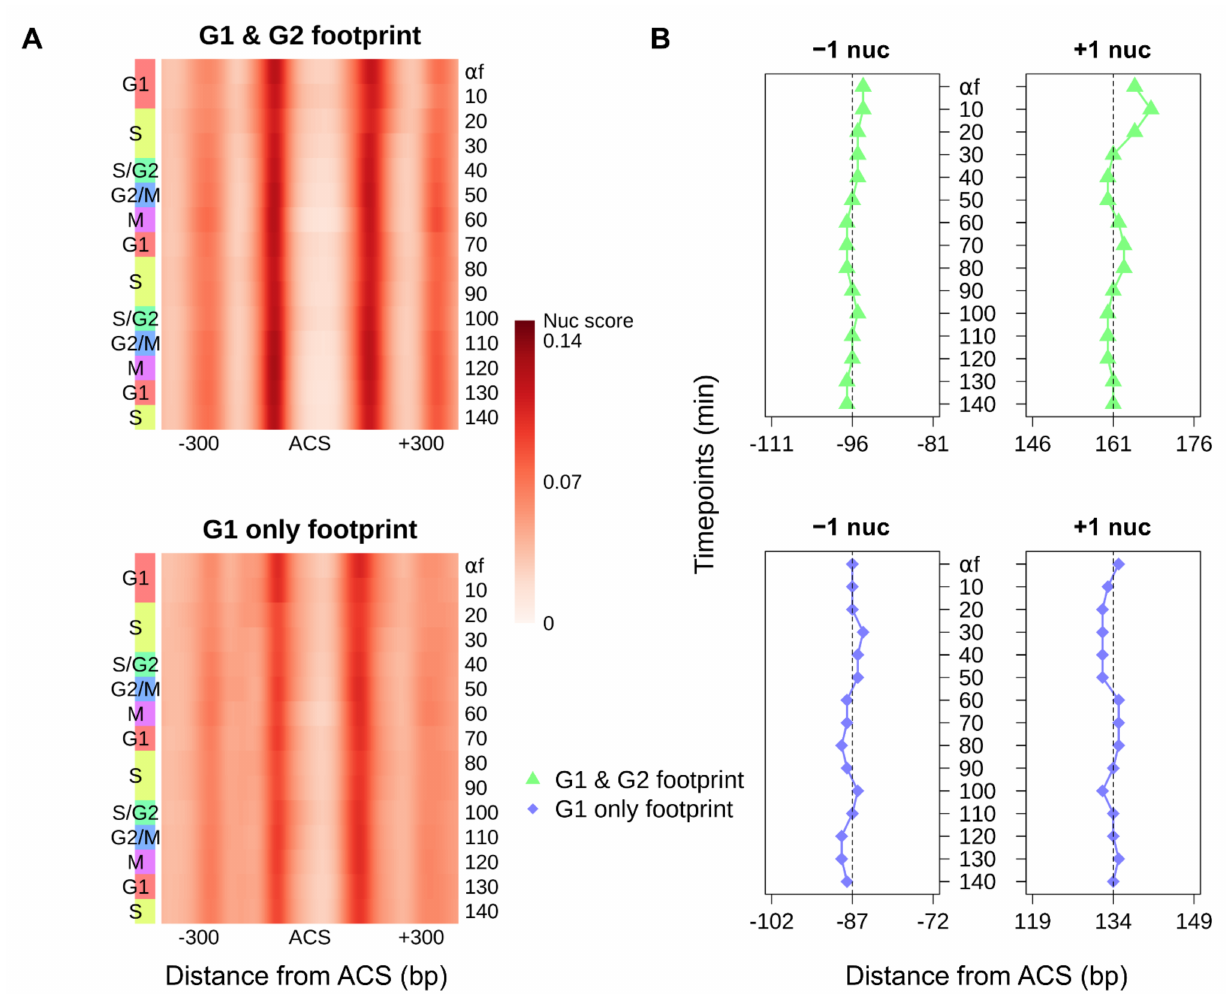
Figure 3. Cell-cycle–dependent nucleosome dynamics at replication origins. ( A ) Heatmaps of aggregate nucleosome scores for 264 origins with an ORC-dependent footprint in both “G1 & G2” (top panel) and 128 origins with an ORC-dependent footprint in “G1 only” (bottom panel) throughout the cell cycle [20]. All origins are oriented by the T-rich ACS strand. ( B ) Dyad positions of the aggregate − 1 and +1 nucleosomes relative to the ACS for each cell-cycle time point and for each class of